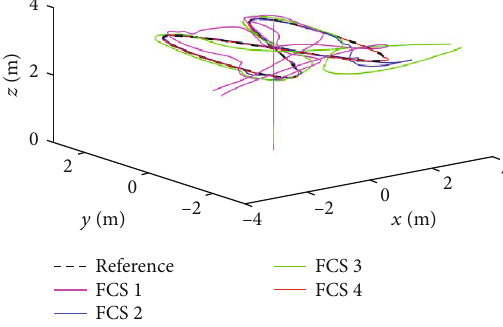
Figure 17: 3D Cartesian fl ight trajectory tracking for di ff erent fl ight control systems: fl ight scenario 2.